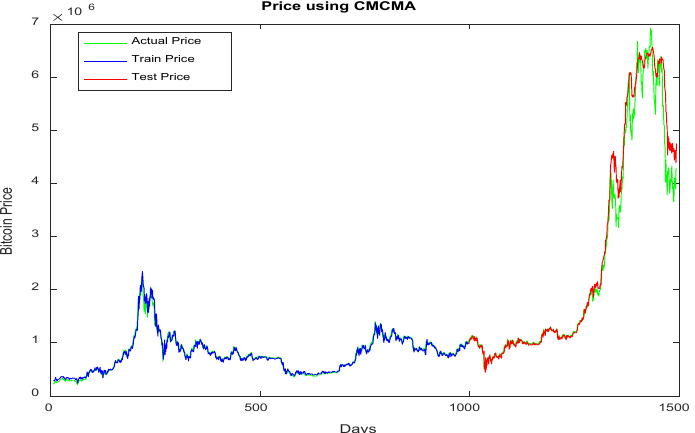
Figure 6. Bitcoin prices using CABCMA for BTC/EUR dataset. Figures 7 and 8 show the actual price, the corresponding training and the testing prices generated by the CMCMA and LMCMA models, respectively, for the BTC/JPY dataset. Again, the CMCMA and LMCMA model approximate Bitcoin prices with very few intervals of over-prediction and under-prediction.